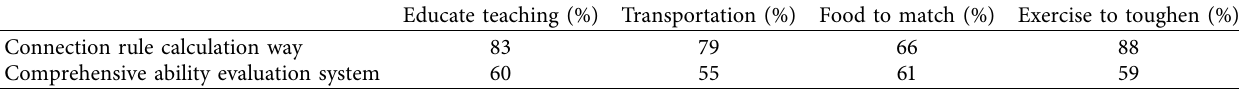
Table 1: The application of association rule algorithm evaluation system in various